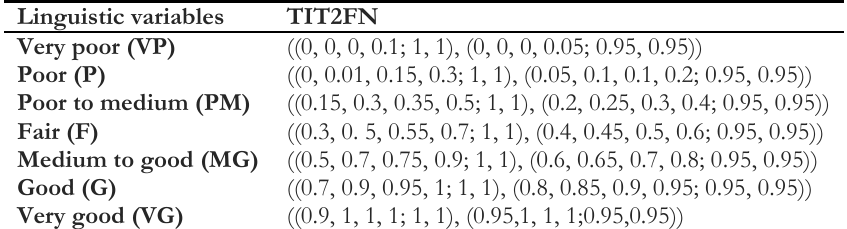
Table 1. Linguistic variables and corresponding TIT2FNs